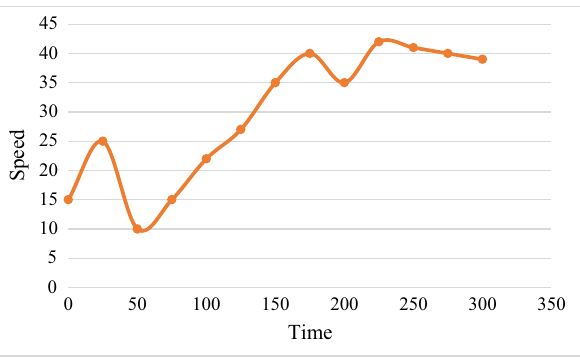
Figure 6: Comparative analysis of traditional and proposed